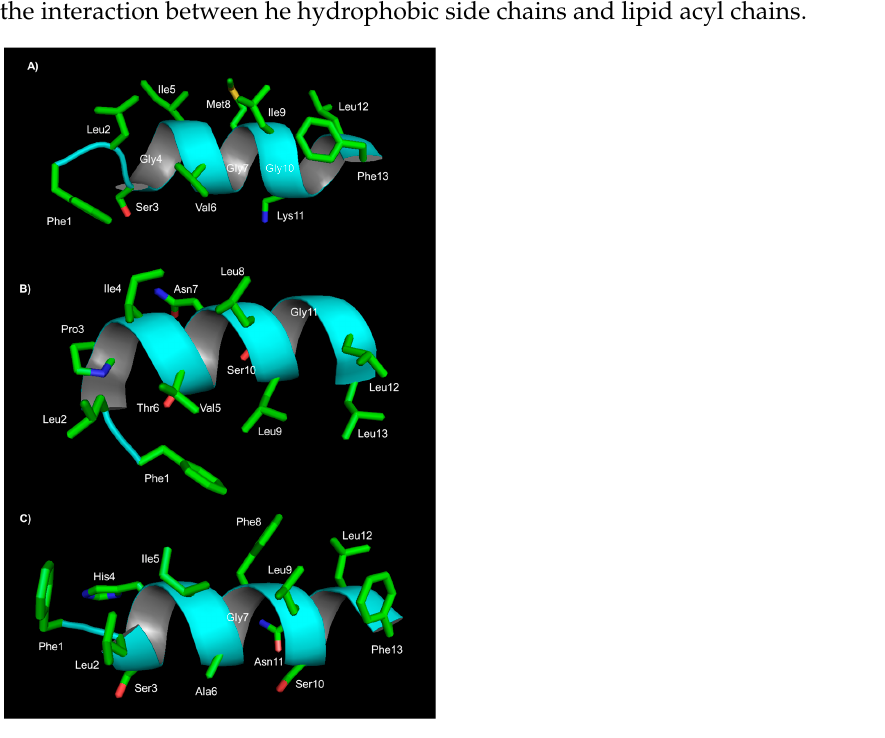
Figure 3. NMR structure in SDS of peptide ( A ) temporin SHa, ( B ) temporin SHb and ( C ) temporin SHc [113].